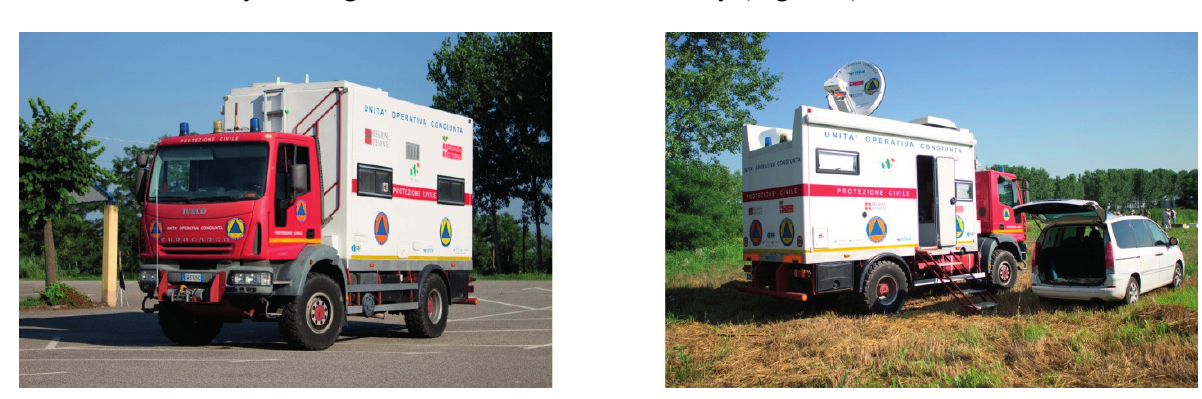
Figure 2. The Regional Civil Protection Mobile Unit, fully equipped with a complete “office” package (including web satellite connectivity): on its way to the test site ( left ) and deployed in the field ( right